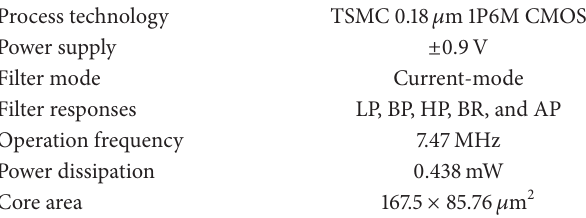
Table 4: Summary of